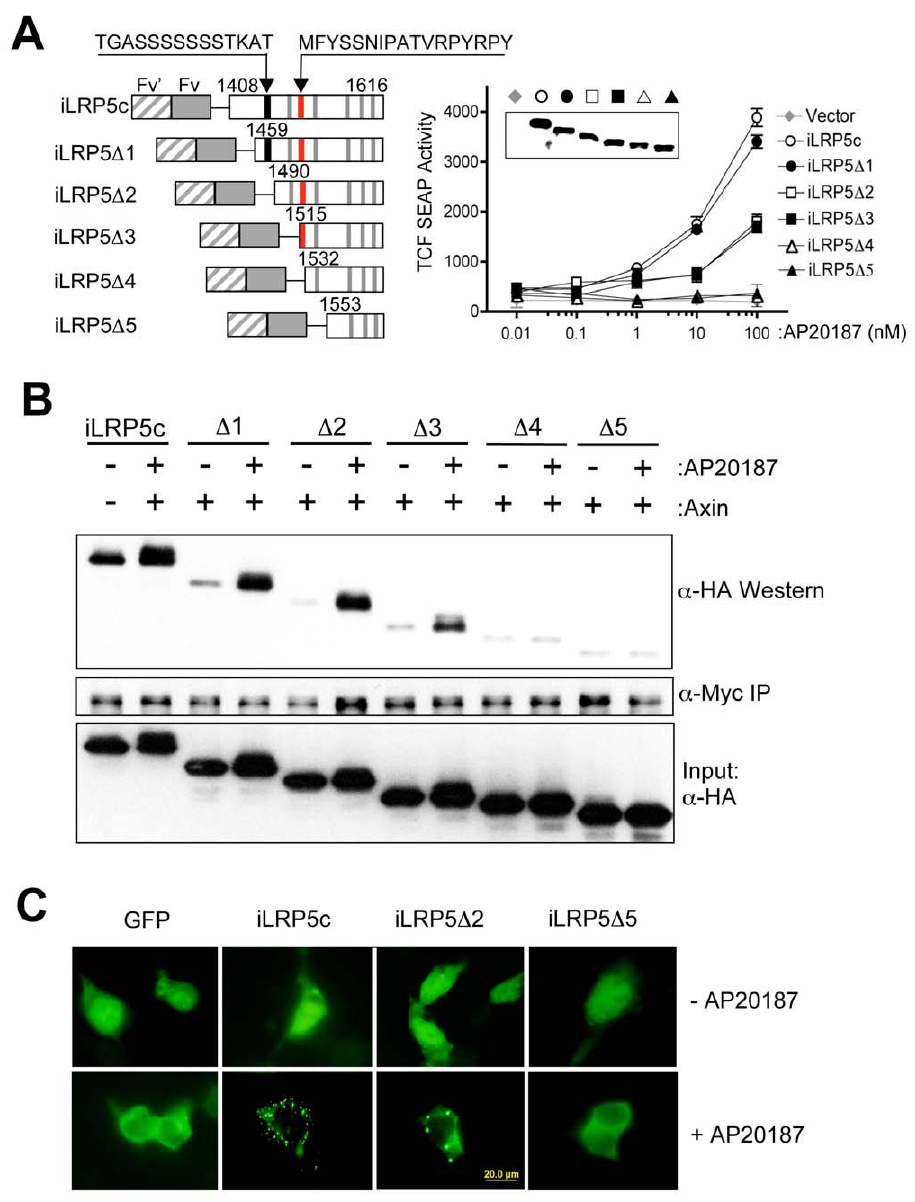
Figure 5. Two distinct regulatory sites in LRP5c are critical for function and localization of iLRP5. ( A ) (left) Schematic of LRP5c deletion mutants (iLRP5 D 1–5) comprised of synthetic ligand-binding domains (F v 9 -F vls ). Numbers indicate N-terminal amino acid position of each deletion mutant. Red and black lines represent indicated sequences and gray lines represent PPPSP motifs, respectively [24]. (right) Domain analysis of LRP5c on Wnt/ b -catenin signaling. 293 cells were transiently transfected with 1 m g each of indicated constructs along with TCF-SEAP reporter. After 24 hours, cell aliquots were treated with indicated concentrations of AP20187, and SEAP activity was measured after an additional 24-hour incubation. Data represent two independent experiments with similar results. ( B ) Role of novel and CK1 sites in the interaction of Axin and iLRP5. 293 cells were transfected with 1 m g each of indicated mutants of iLRP5 along with an Axin expression construct. After 24-hour treatment with 100 nM AP20187 ( + CID), Axin was immunoprecipitated from whole cell lysates with anti-myc antibody ( a -myc). Co-immunoprecipitation of LRP5c was analyzed by anti-HA blot ( a -HA). Amount of iLRP5 mutant expression was determined by HA blot (Input: a -HA). ( C ) Subcellular localization of iLRP5- truncation mutants. 293 cells were transfected with 1 m g of indicated plasmids. Twenty-four hours after transfection, 100 nM FK1012 was added for an additional 24 hours to induce dimerization. After fixation, cells were examined by fluorescence microscopy.